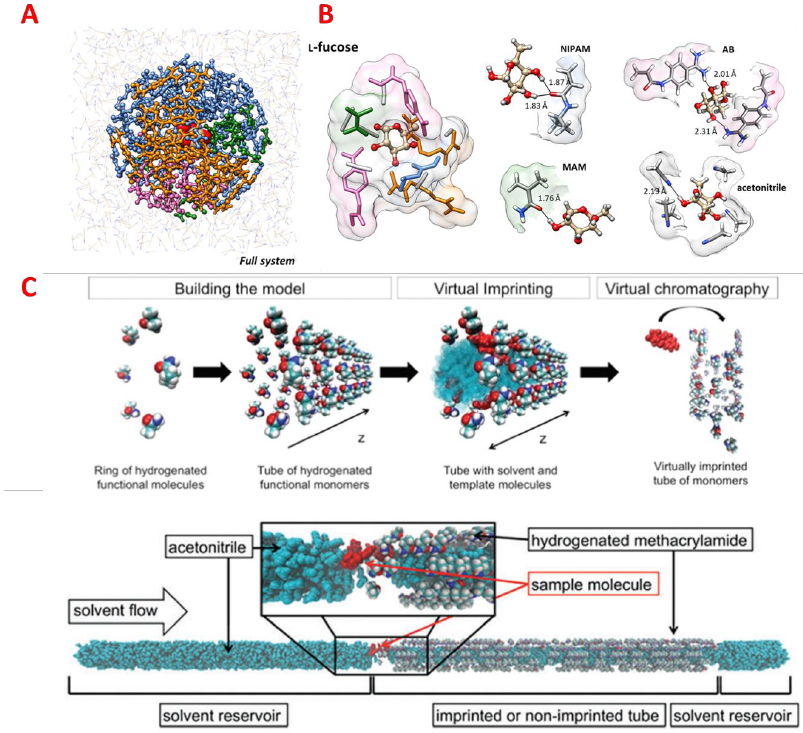
Figure 1. ( A ) Structure of a representative pre-polymerization system used as an input model for MD simulations. The template (spheres representation) is located at the origin of the simulated system and surrounded by a spherical shell of 48 functional monomers ( N -isopropylacrylamide (NIPAM), pink; acrylamidophenyl(amino)methaniminium acetate ( A , B ), orange; methacrylamide (MAM), green, 48 cross-linker units (ethylene glycol dimethacrylate (EGDMA)) blue; and an explicit solvent box (acetonitrile), gray. ( B ) Examples of prepolymerization complexes and hydrogen-bonding interactions observed with target template (l-fucose). Reprinted with permission from [36], Copyright 2021, American Chemical Society. ( C ) Virtually imprinted tubes templated with 17- β -estradiol demonstrate the concept for virtual chromatography experiment simulations;. The template is represented by the red molecule, the functional monomers by the colorful molecules and the solvent by the cyan molecules. Reproduced from [37] with permission from the Royal Society of